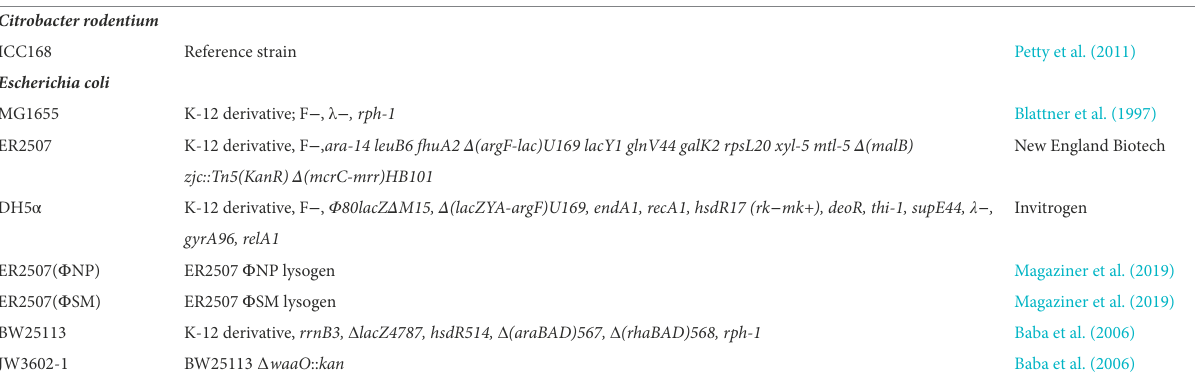
TABLE 1 Bacterial strains used in this study.